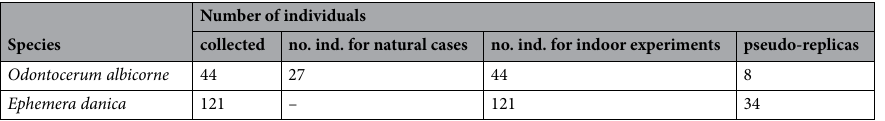
Table 1. Number of individuals (no. ind.) for each species: collected in field, used for observations of natural cases and indoor experiments, and pseudo-replicas experiments.